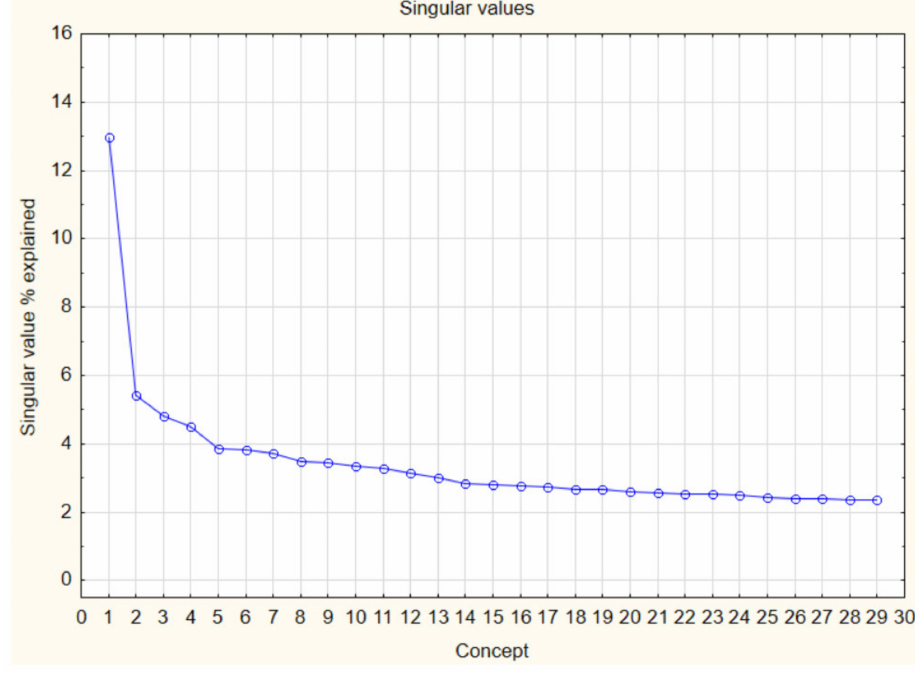
Figure 4. SVD value percentages of concepts.